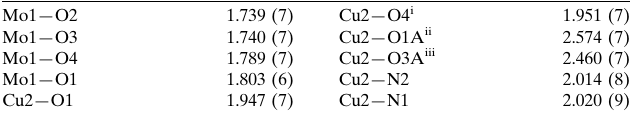
Selected bond lengths (A˚